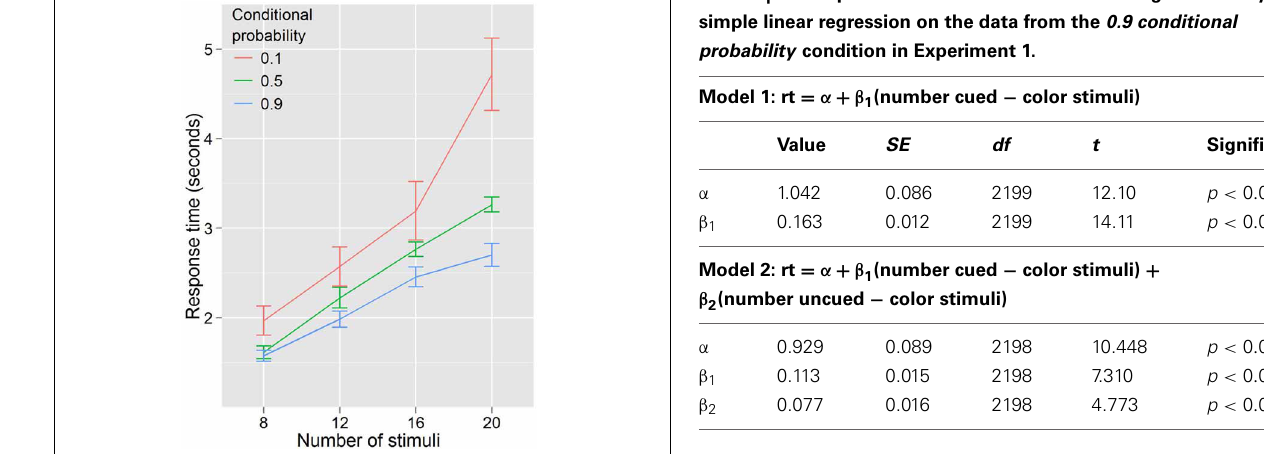
conditional probability (3 levels: 0.1, 0.5, 0.9) and number of stimuli (4 levels: 8, 12, 16, 20) as factors ( Figure 3 ) found that RT increased with number of stimuli, F ( 3 , 27 ) = 96 . 29, p < 0 . 001, and decreased with conditional probability, F ( 2 , 18 ) = 18 . 01, p <